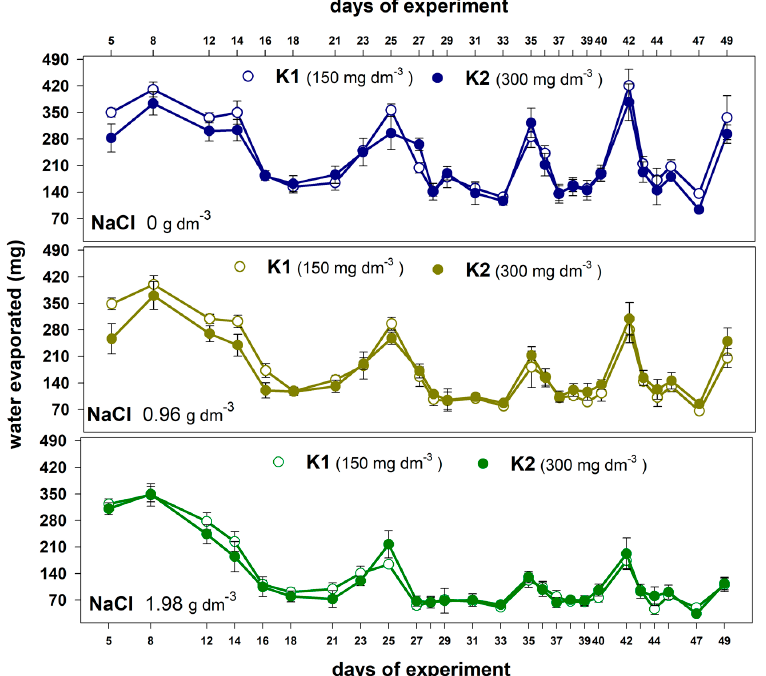
Figure 3. The effect of potassium dose (K1 and K2) on water evaporated during the experiment from the containers with plants grown in the substrate without salt and substrate supplemented with two NaCl doses. Values are expressed as the means (n = 5) ± standard deviation.